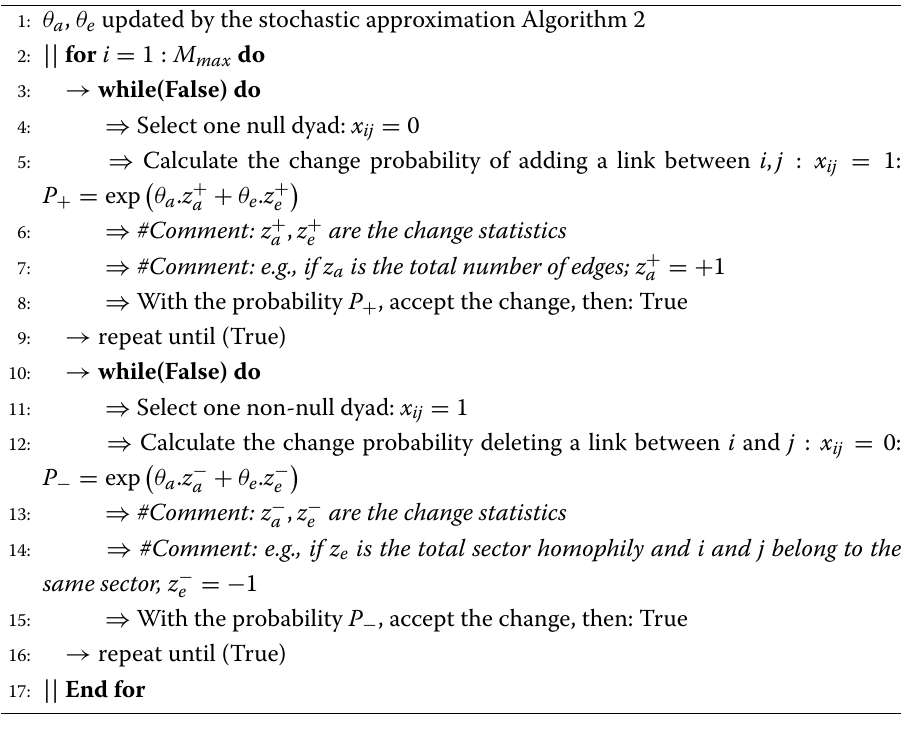
Algorithm 1 The fixed-density Markov chain Monte Carlo sampler: This algorithm allows sampling of networks based on the parameters (cid:2) s. It is called in the following algorithm